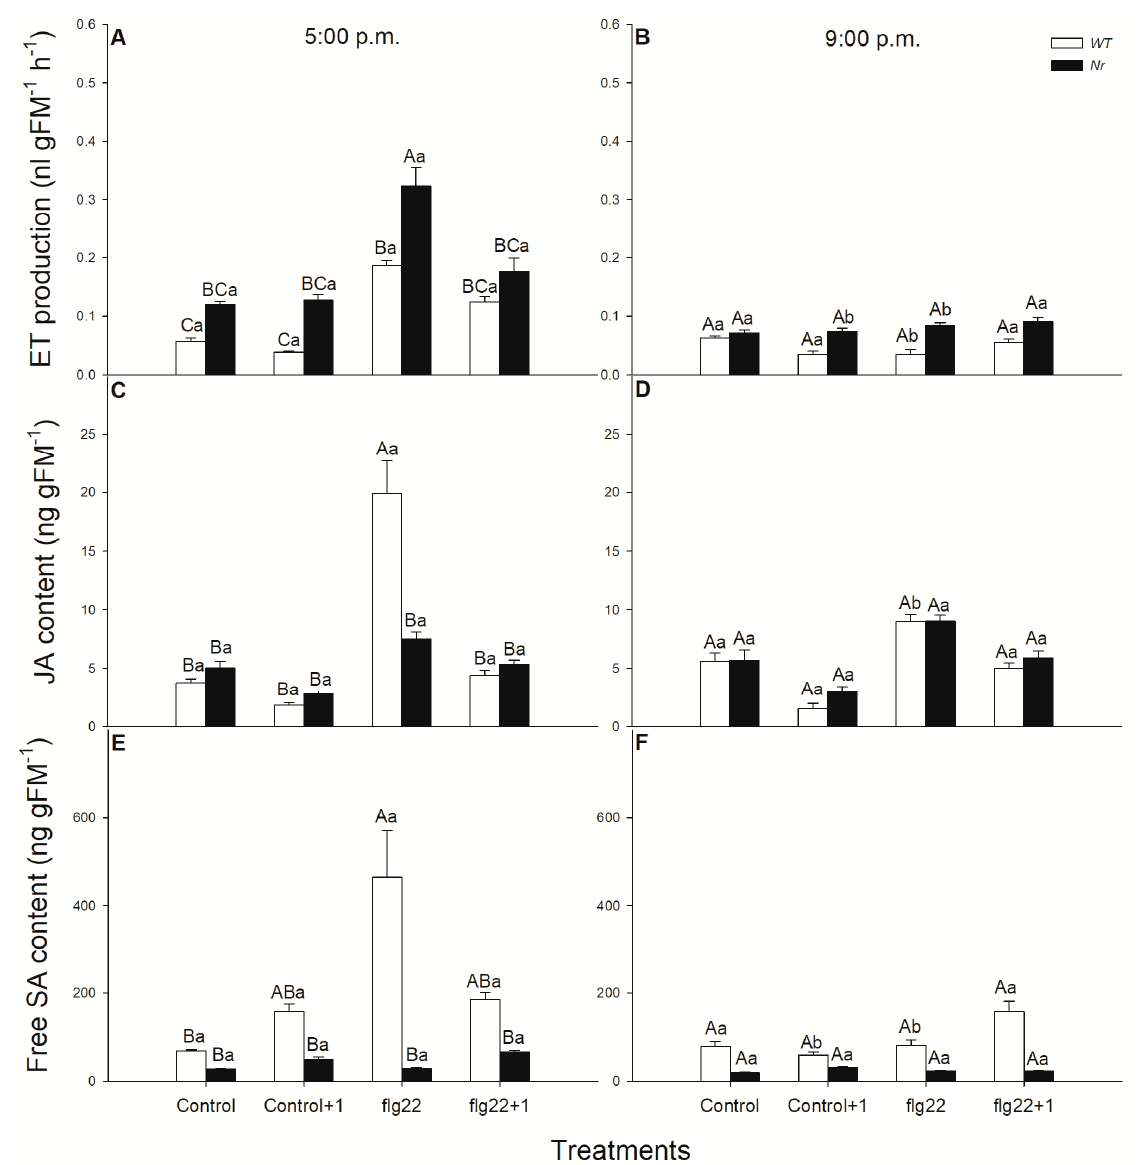
Figure 3. Changes in the ethylene (ET) emission ( A , B ), jasmonic acid (JA) content ( C , D ) and salicylic acid (SA) content ( E , F ) in leaves of intact wild type (WT; white columns) and ethylene-insensitive Never ripe ( Nr ; black columns) tomato plants treated foliar using a squirrel-hair brush with 5 μ g mL − 1 of flagellin (flg22) in the late afternoon under light (at 5:00 p.m.) or at night under darkness (at 9:00 p.m.). Measurements were carried out one hour after treatments (at 6:00 p.m. and 10:00 p.m.). Whole leaves from the different leaf levels and genotypes were collected and immediately frozen in liquid nitrogen; then, hormone levels were determined by chromatography methods. Means ± SE, n = 3. Means were analysed by two-way ANOVA; significant differences among the data were analysed by Duncan’s test. Mean values significantly different at p < 0.05 are indicated by different letters, upper case letters indicate the effects of the treatment at the same time of day and lower case letters indicate the effects of daytime under the same treatment. (Control, treatment with sterile distilled water; Control+1, untreated distal leaf level to the control; flg22, treatment with 5 µ g mL − 1 of flagellin dissolved in sterile distilled water; flg22+1, untreated distal leaf level to the flg22-treated